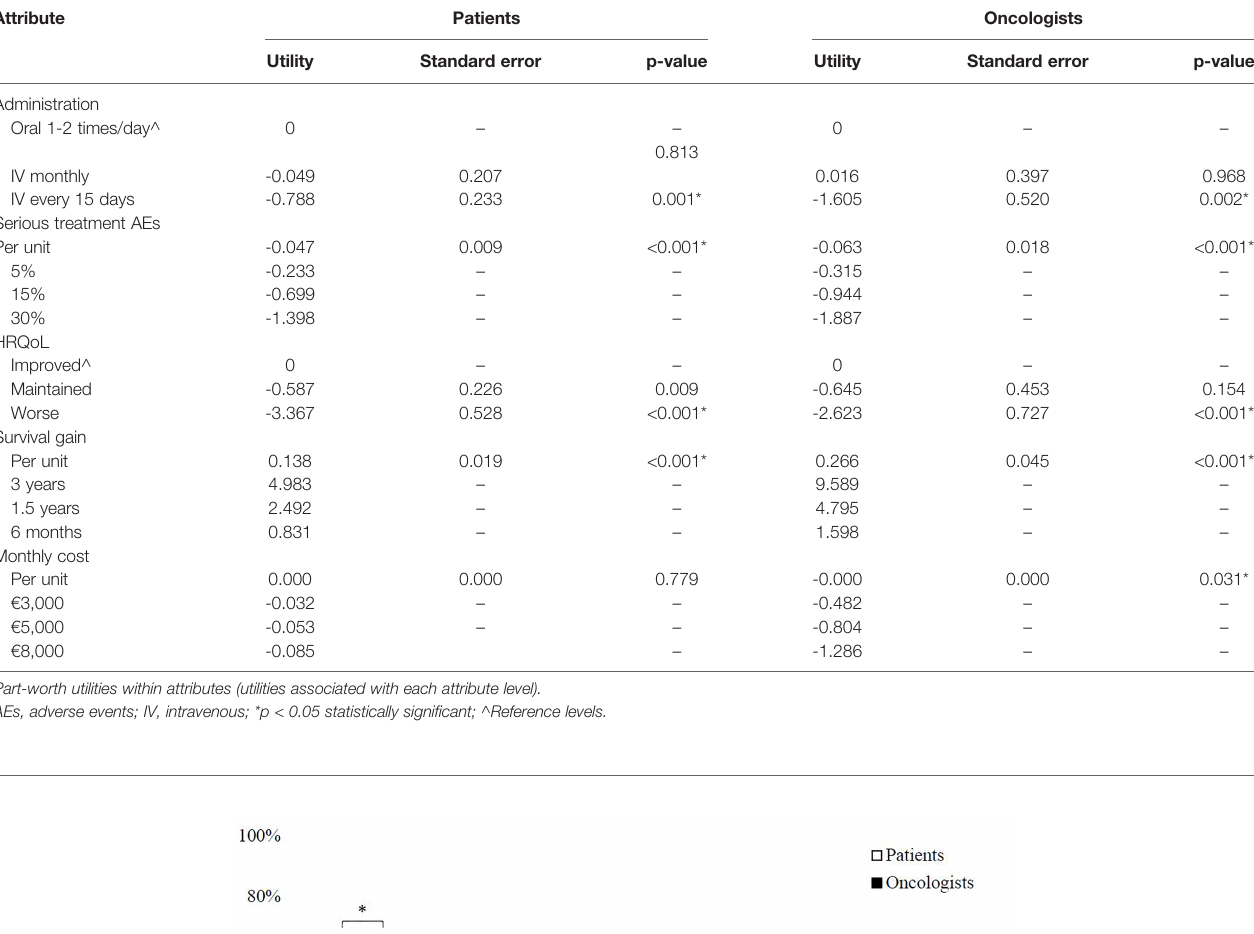
TABLE 4 | Utility scores in RCC patients and oncologists.